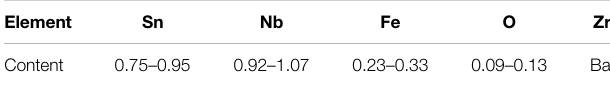
TABLE 1 | Chemical composition of the Zr – Sn – Nb alloy (wt%).